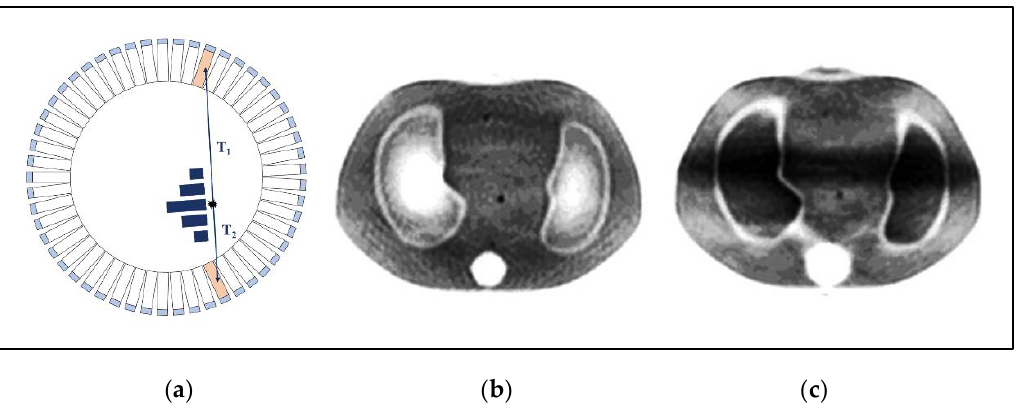
Figure 3. ( a ) Principle of TOF-PET. PET phantom images after ( b ) TOF reconstruction and ( c ) non-TOF reconstruction [58].